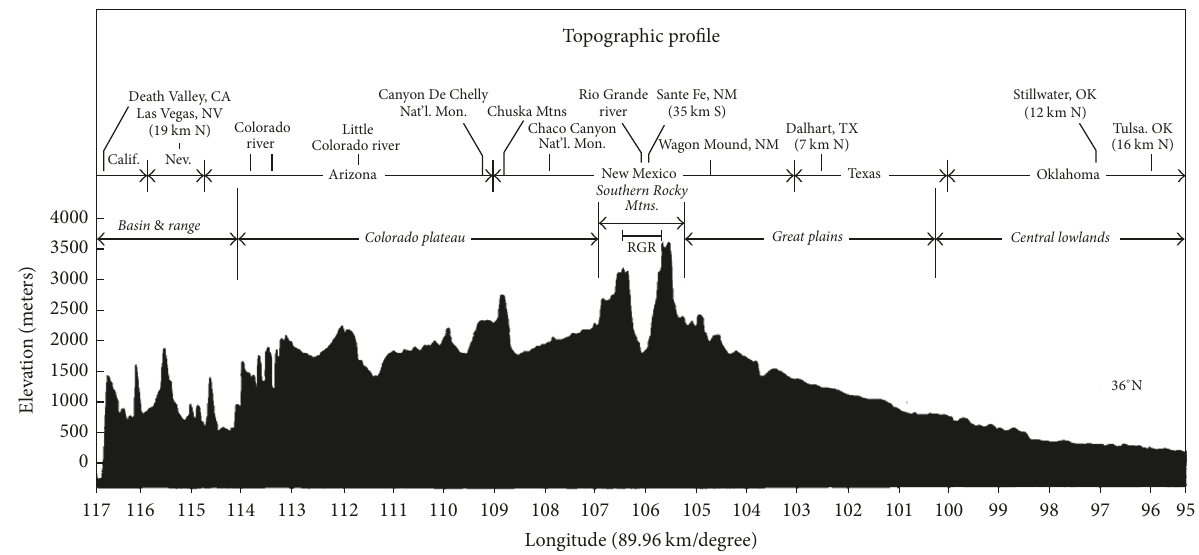
Figure 4: Cross-section of the Eaton Alvarado ridge along the 36 ∘ N parallel. The cross-section shows the Rio Grande rift incised into the Alvarado ridge (Figure 3 of [11]).